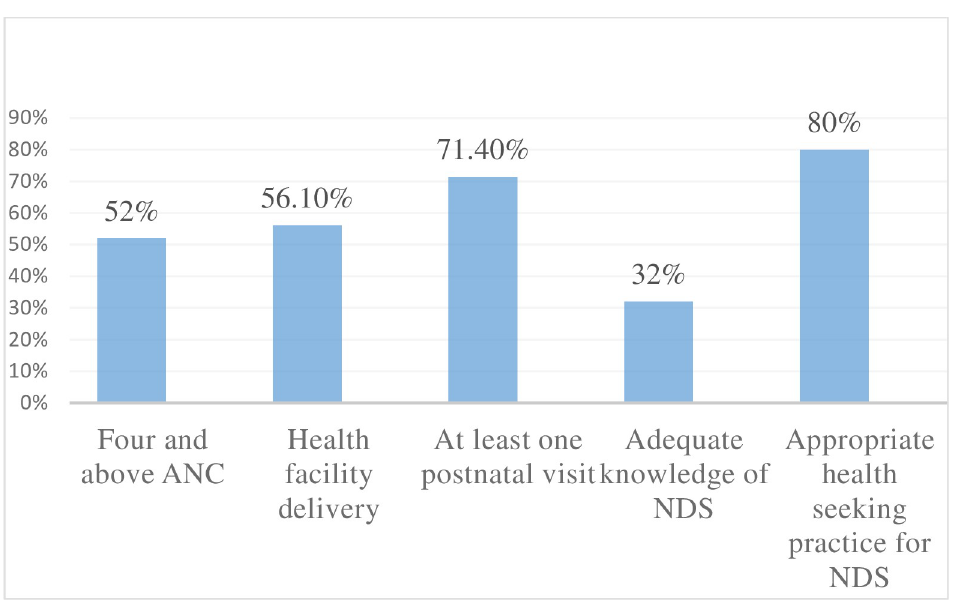
Fig 1. Maternal and neonatal healthcare service utilization among autonomous women in Debretabor northwest Ethiopia, 2019.